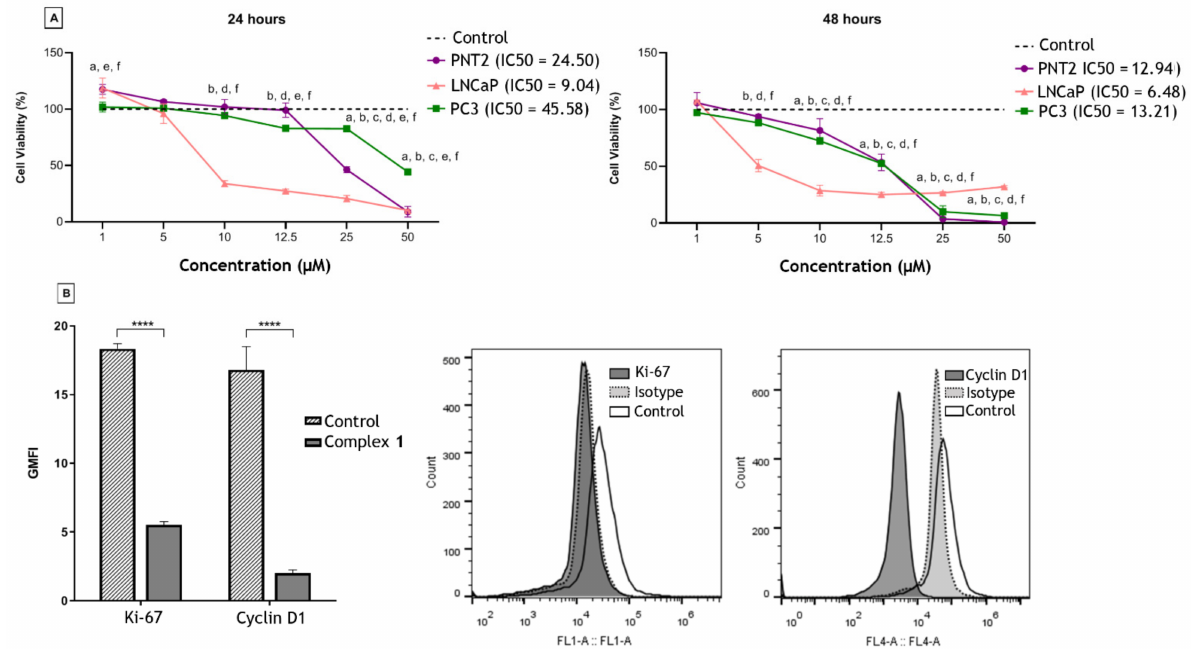
Figure 2. Effects of complex 1 on prostatic cell lines. ( A ) Cytotoxic activity of complex 1 on non- tumorigenic lineage PNT-2 and the tumor lines LNCaP (hormone-responsive) and PC-3 (androgen- independent) after 24 and 48 h of treatment. a: comparison between PNT-2 and control; b: comparison between LNCaP and control; c: comparison between PC-3 and control; d: comparison between PNT2 and LNCaP; e: comparison between PNT2 and PC-3; f: comparison between LNCaP and PC-3. IC50 is also presented. ( B ) Expression analysis of Ki-67 and Cyclin D1 on LNCaP cells by flow cytometry (white peak). Secondary antibody alone was used (traced gray peak). **** p < 0.0001. Results were presented as mean ± SD of three independent experiments repeated three times. Control was cells treated with dimethyl sulfoxide